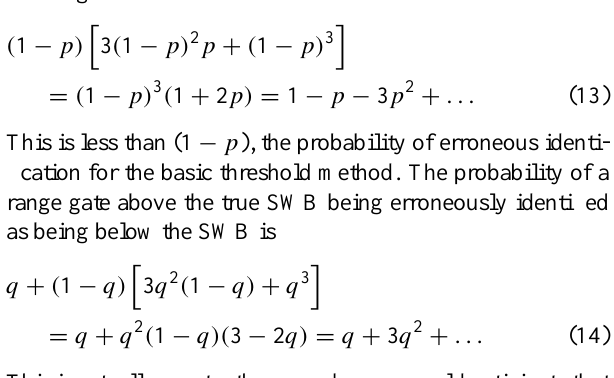
Fig. 5. The variation of the percentage of identified boundaries and the rms boundary error with changing spectral width threshold, as estimated by the application of algorithm 2 to the simulated data